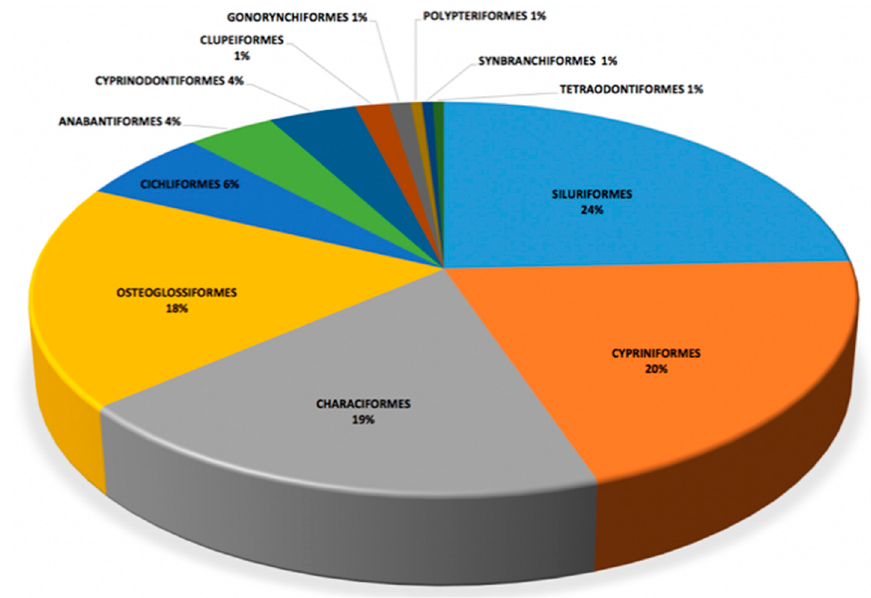
Figure 4. Relative representation of each order in the lower Lulua River.